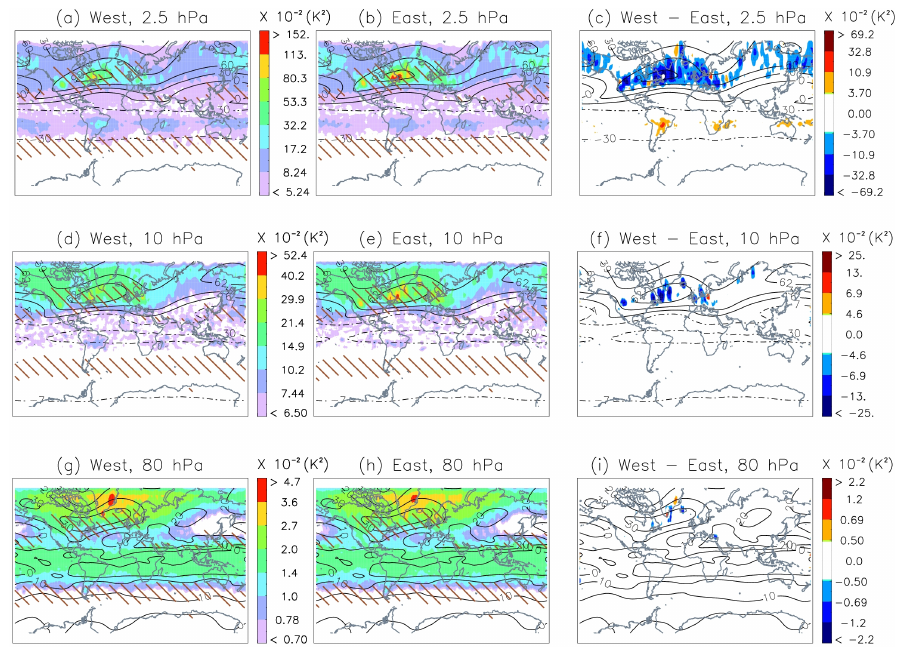
Fig. 5. Geographical distribution of GW variance on a 2 ◦ × 2 ◦ grid at westmost view (left column), eastmost view (middle column) and the difference (right column) for January 2005 at 2.5, 10, and 80hPa from top to bottom. 3-pt smoothing has been further applied to make the signals stand out. In the left two columns, values smaller than 2 σ are uncolored, where σ is the minimum detectable variance. In the rightmost column, absolute values smaller than the minimum detectable difference are whitened. The UK Met Office monthly mean zonal winds at corresponding levels are contoured in black solid (westward) and dotted (eastward) lines. Total wind velocity greater than 10ms − 1 areas at 700hPa are hatched with brown lines.